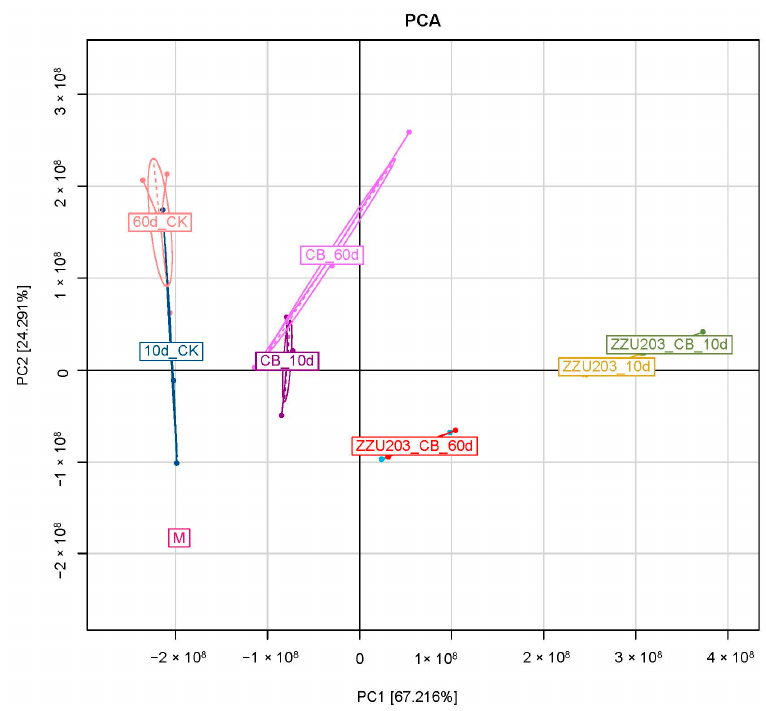
Figure 5. Principal coordinate analysis of bacterial communities in alfalfa silage based on the results illustrated by AQS.